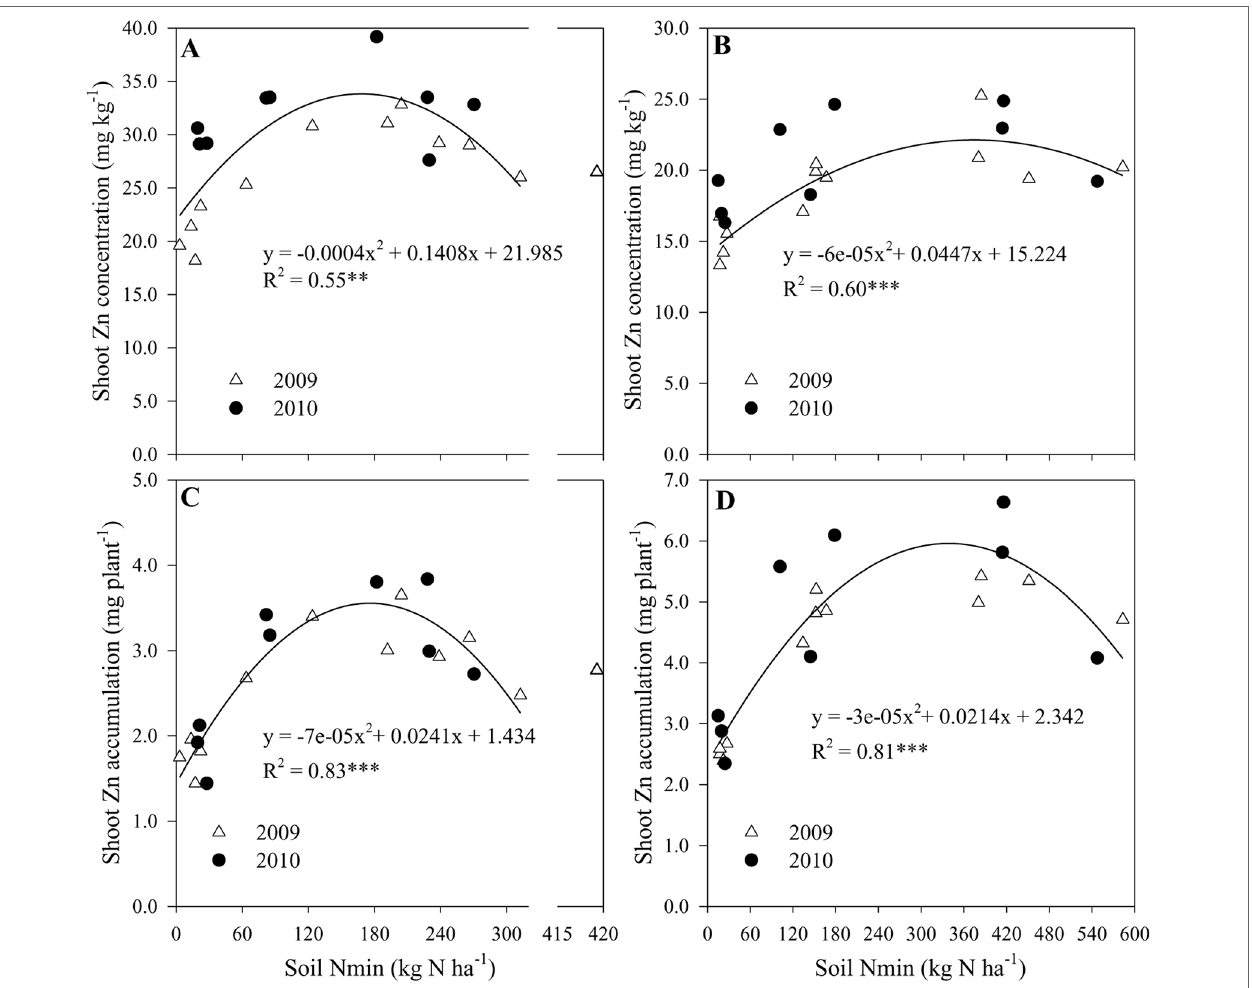
FIGURE 4 | The shoot concentration and accumulation of Zn at R1 (A , C) and R6 (B , D) growth stages, respectively as function of an increasing N availability in soil at 0–90 cm in 2009 and 2010. ** and *** indicate significant difference at P < 0.01 and < 0.001,